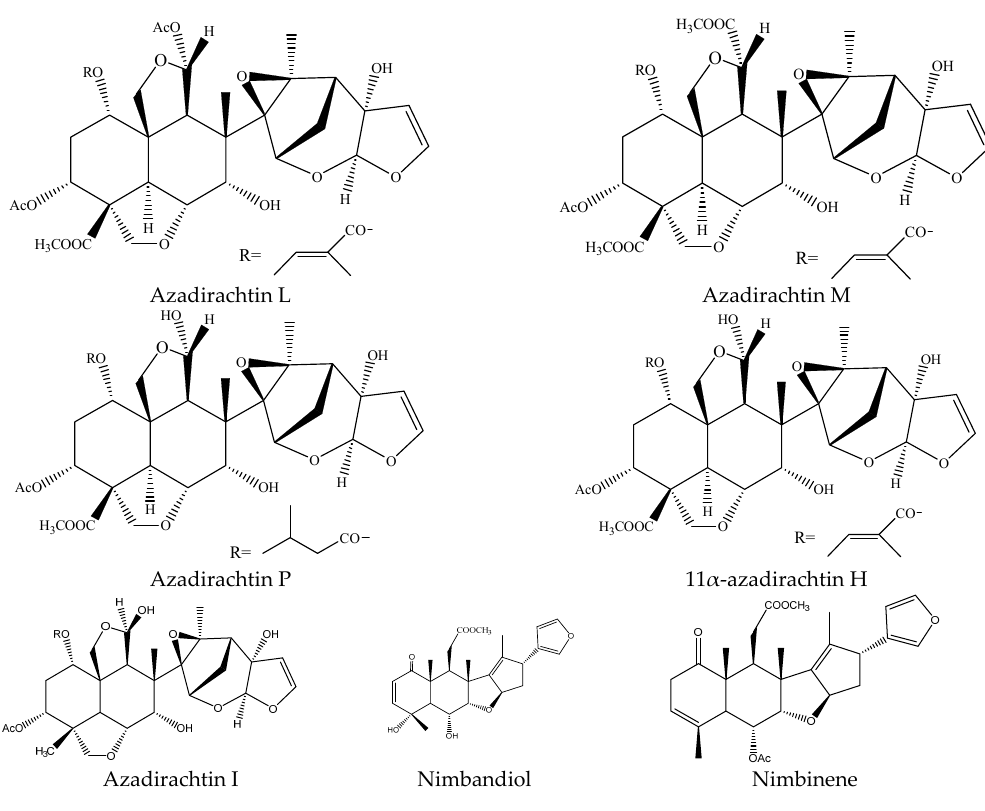
Figure 17. The structures of pentanortriterpenoids.